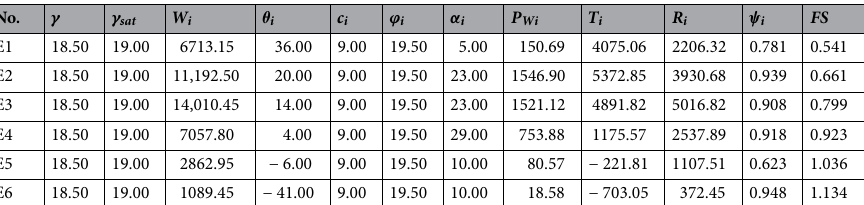
Table 3. Calculation results of the slope stability in cross section 3-3 ′ (without considering rainfall). See “Theoretical calculation” section for the meaning and unit of each